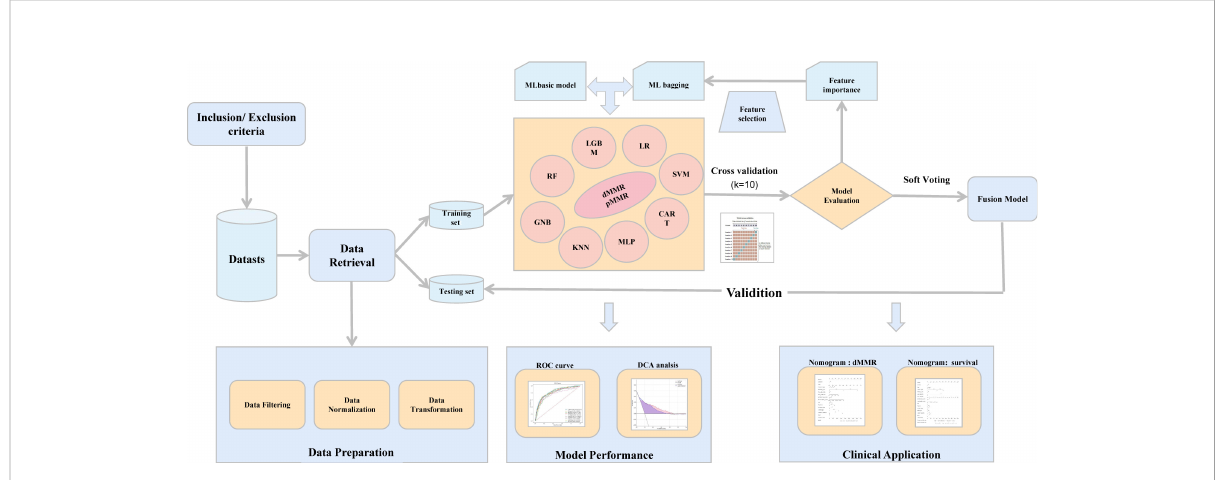
FIGURE 1 The work fl ow of the study. ML, machine learning; ROC, receiver operating characteristic; DCA, decision curve